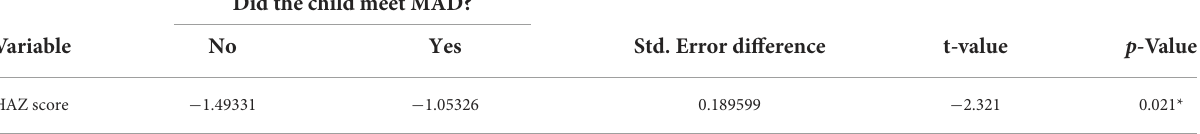
Did the child meet MAD?